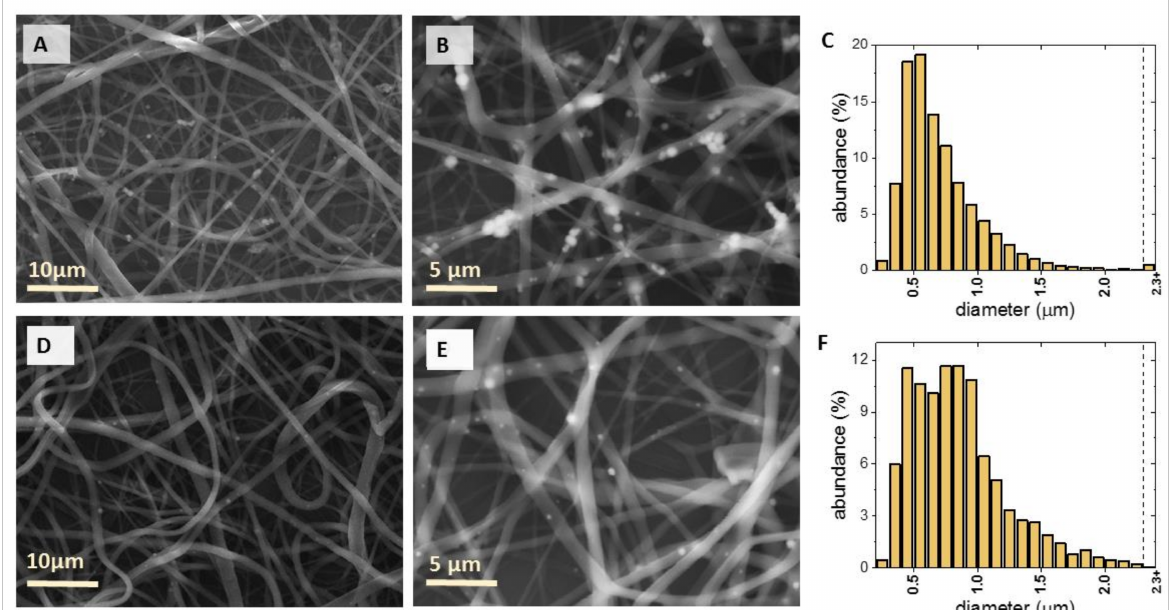
Figure 3. SEM images and fiber diameter distribution of PCL nanofibres loaded with 6 wt.% ( A – C ) and 2 wt.% ( D – F ) magnetite nanoparticles respectively.